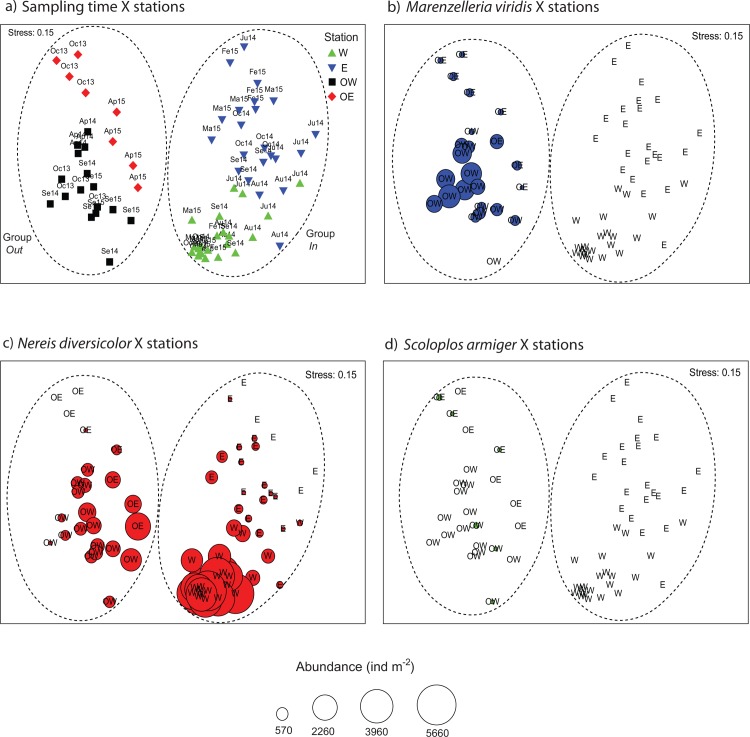
Two-dimensional plots of MDS outputs based on Bray-Curtis similarity matrix.Panel (a): distribution of fauna dataset indicated by time and station. Time is represented as month by the two first letters and year by the two last numbers. Sampling months: February, April, May, July, August, September, and October. Sampling years: 2013 to 2015. Sampling stations: Western site inside the lagoon (W), Eastern site inside the lagoon (E), Western site outside the lagoon (OW), and Eastern site outside the lagoon (OE). The dashed ellipses indicate the groups of stations tested by ANOSIM analysis: Group Out composed of stations located outside the lagoon and Group In composed of stations inside the lagoon. Panels (b), (c) and (d): spatial and temporal abundance of species tested in the laboratory experiment.